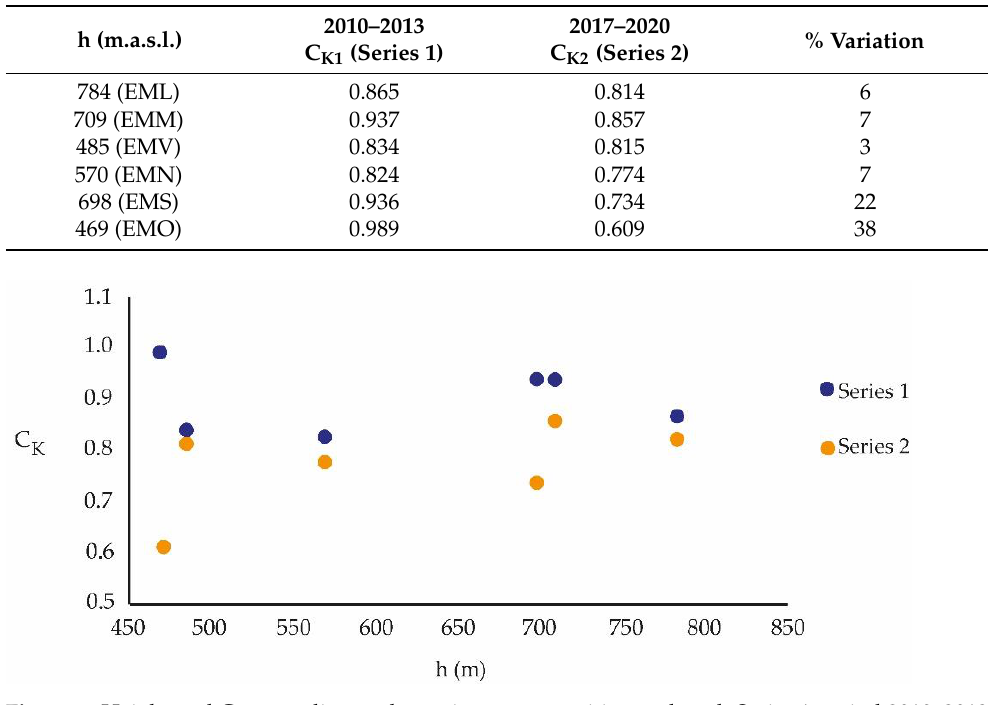
Figure 5. Height and C K according to the various communities analyzed. Series 1 period 2010 – 2013 and Series 2 period 2017 –